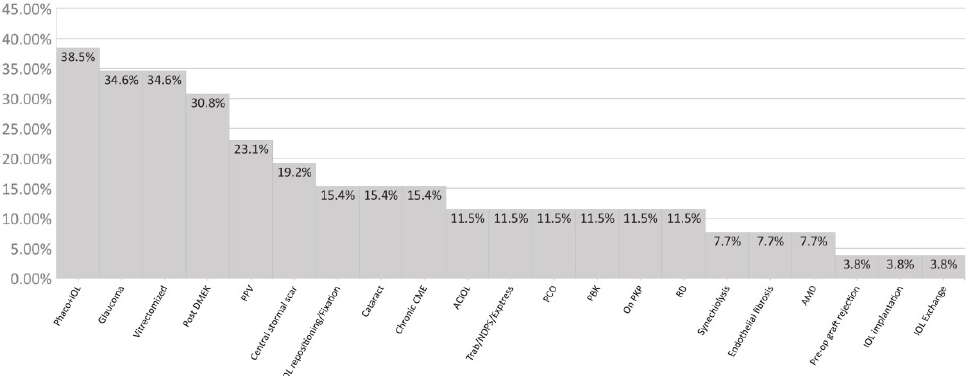
Figure 2. Ocular comorbidities of the patients before DMEK “Wave Maneuver”. Rehabilitation and visual acuity outcome. PPV: pars plana vitrectomy; Phaco + IOL: phacoemulsification with an intraocular lens (IOL); Pre-op: pre-operated; NPDS: non-penetrating deep sclerectomy; Elevated IOP: over 26 mm/hg corrected intraocular pressure; PCO: posterior capsule opacification; CME: cystoid macular edema; PBK: pseudophakic bullous keratopathy; PKP: penetrating keratoplasty; AMD: age-related macular degeneration; DMEK: Descemet membrane endothelial keratoplasty, RD: retinal detachment.